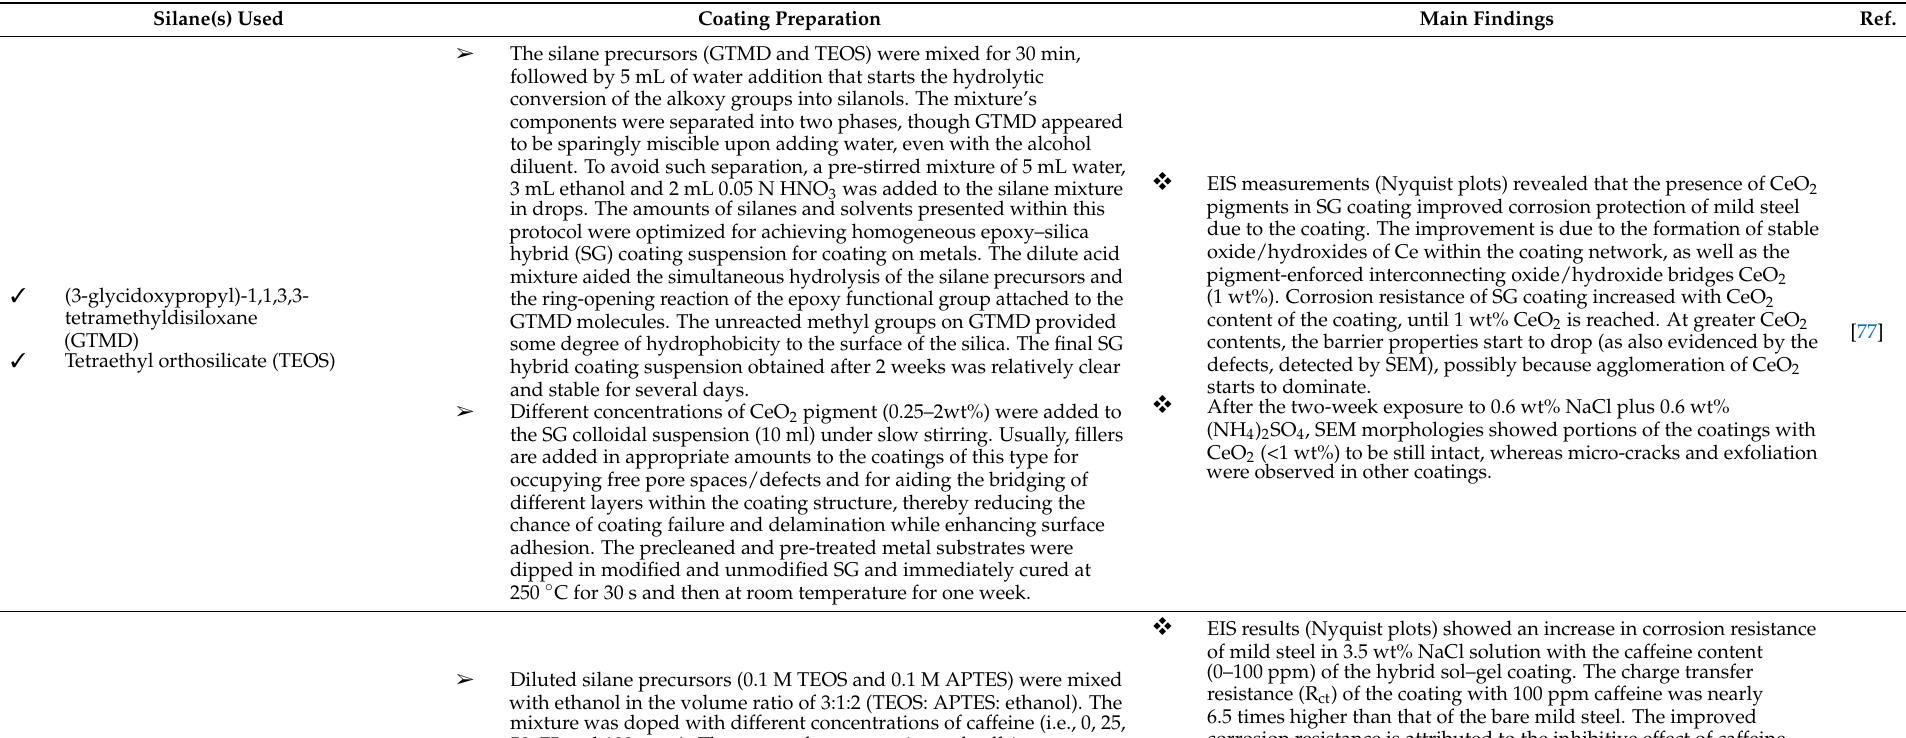
Table 1. Different approaches for improving silane coatings and the main findings, as reported in the literature.